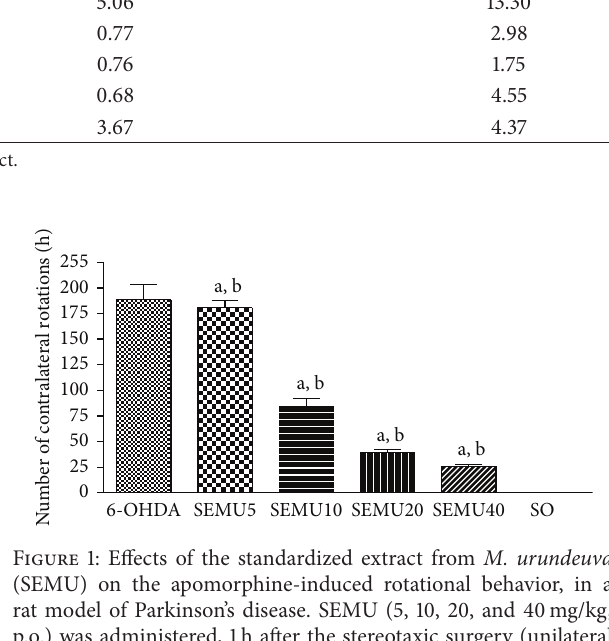
Table 1: Percentages of total tannins, other polyphenols, and total polyphenol contents in cultivated Myracrodruon urundeuva Fr. All. Plant part